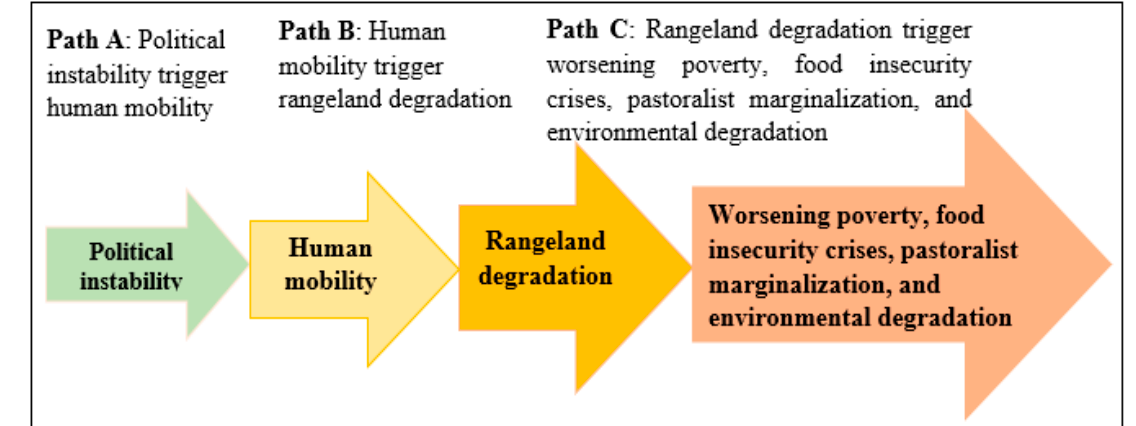
Figure 1. Conceptual path of the impact of political instability on pastoralist livelihood.